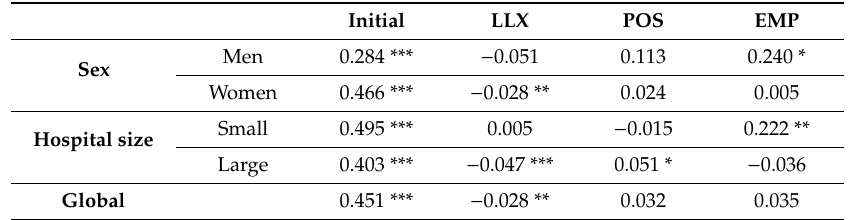
Table 2. Regression coe ffi cients (initial and after three moderations) for the LMX-commitment relationship; global and stratified values by sex and hospital